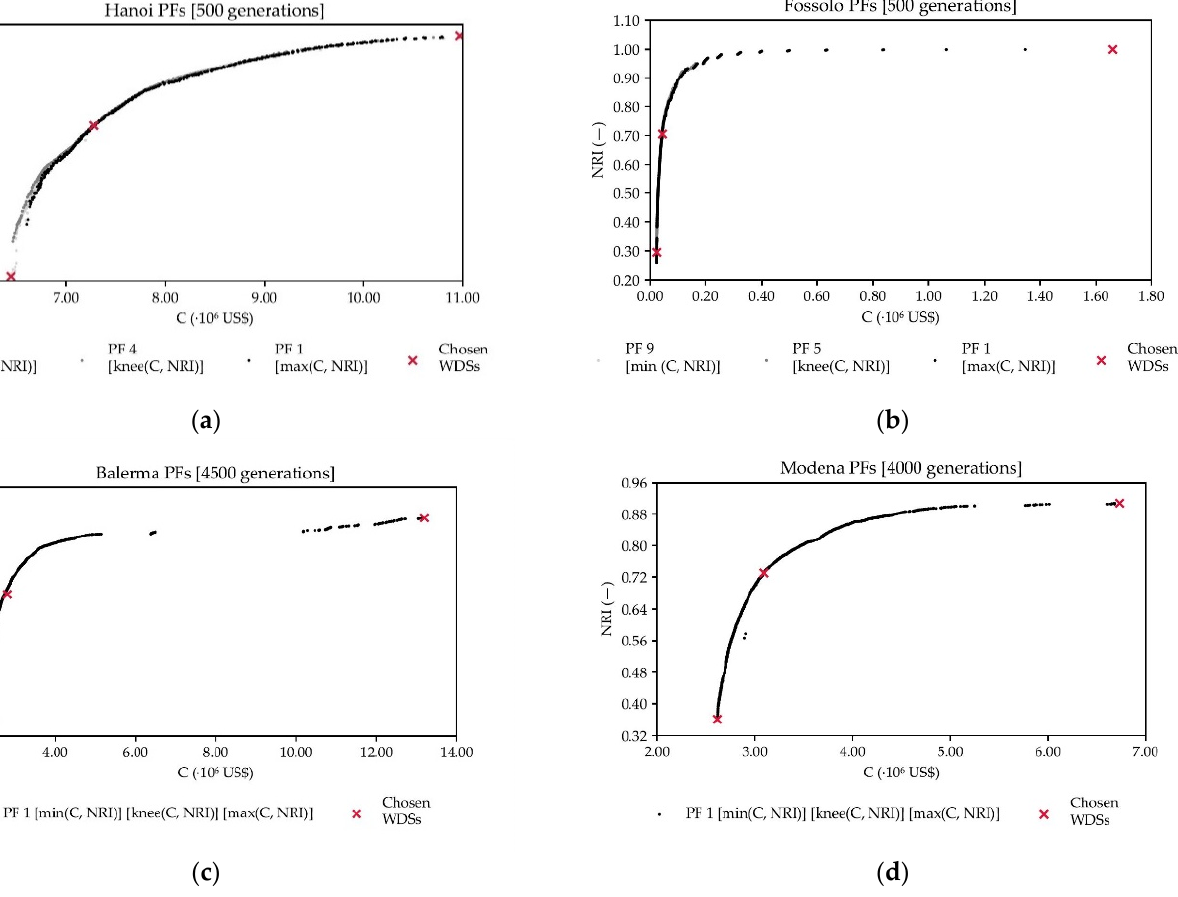
Figure 2. Selected individuals from retrofitted OPUS/NSGA-II PFs for the: ( a ) Hanoi WDS; ( b ) Fossolo WDS; ( c ) Balerma WDS; and ( d ) Modena WDS.